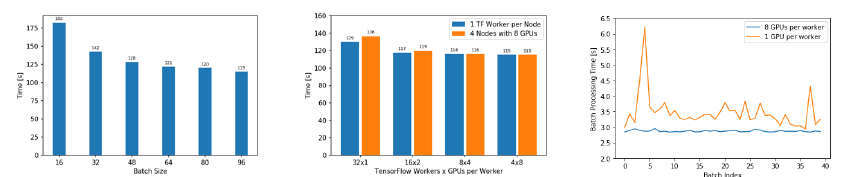
Figure 4. (left) Impact of batch size on time to perform one epoch of training. (center) Impact of various combinations of hardware layout and TF worker configuration on time to perform one epoch of training. Orange represents the first set of runs, where hardware configuration is fixed with 4 nodes with 8 GPUs each, while number of workers and GPUs per worker change. Blue represents the second set of runs where number of workers and GPUs per worker correspond to number of nodes and GPUs per node. (right) Batch processing times for the second epoch of training using hardware layout with 4 nodes with 8 GPUs per node. Orange represents the batch processing times when number of workers is 32 and each worker has 1 GPU, Blue represents the batch processing times when number of workers is 4 and each worker has 8